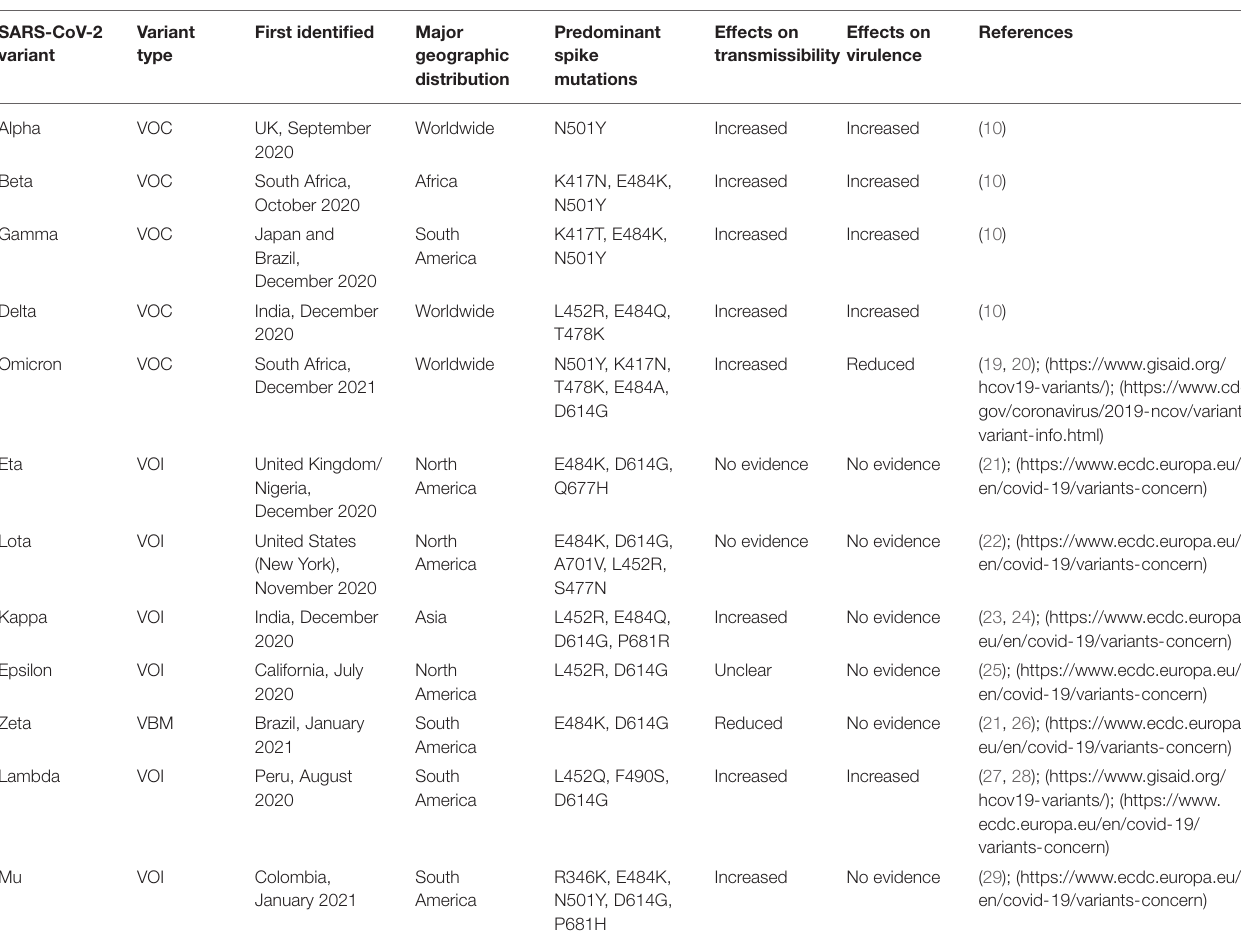
TABLE 1 | History and major characteristics of SARS-CoV-2